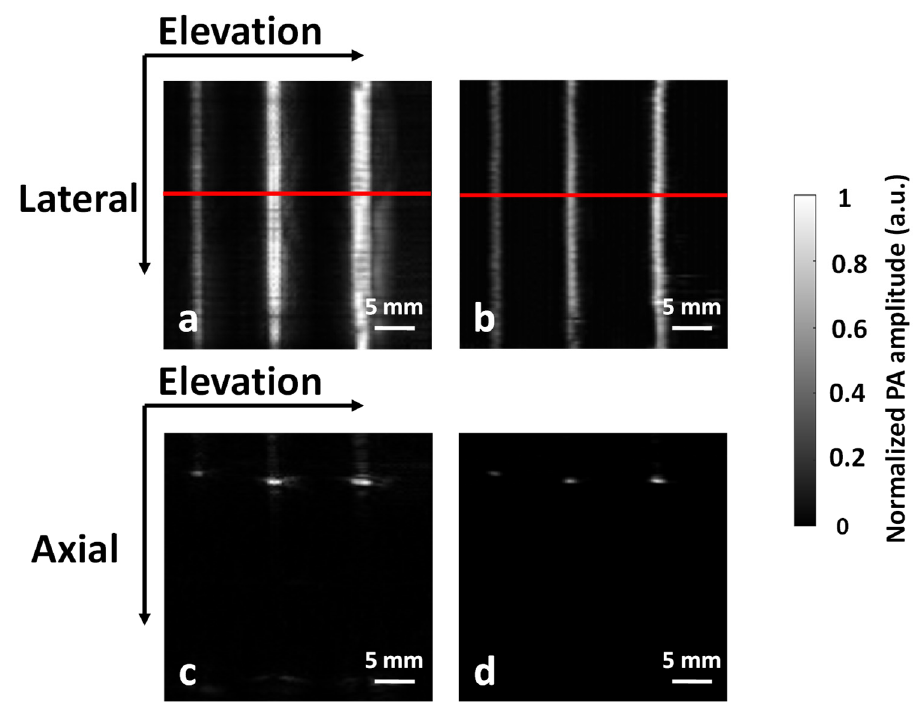
Figure 6. Imaging results of pencil leads of different diameters. ( a ) Input reconstructed by the 3D focal-line algorithm. ( b ) Combined (2D Deep-E and 3D Deep-E) output. ( c ) Cross-sectional image obtained from the location indicated by the red line in ( a ). ( d ) Cross-sectional image obtained from the location indicated by the red line in ( d ).